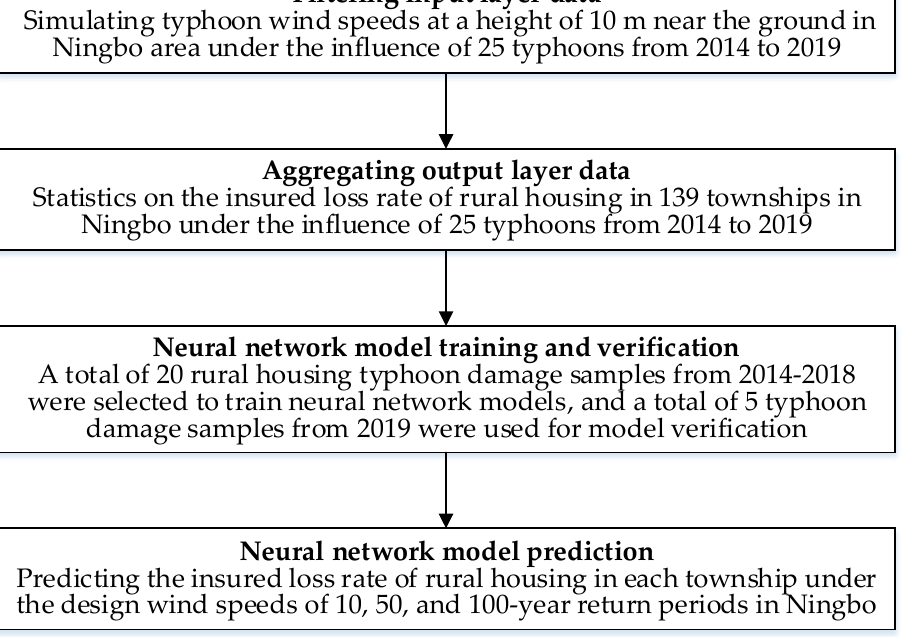
Figure 4. The flow chart for construction of typhoon loss assessment model for rural housing in Ningbo.